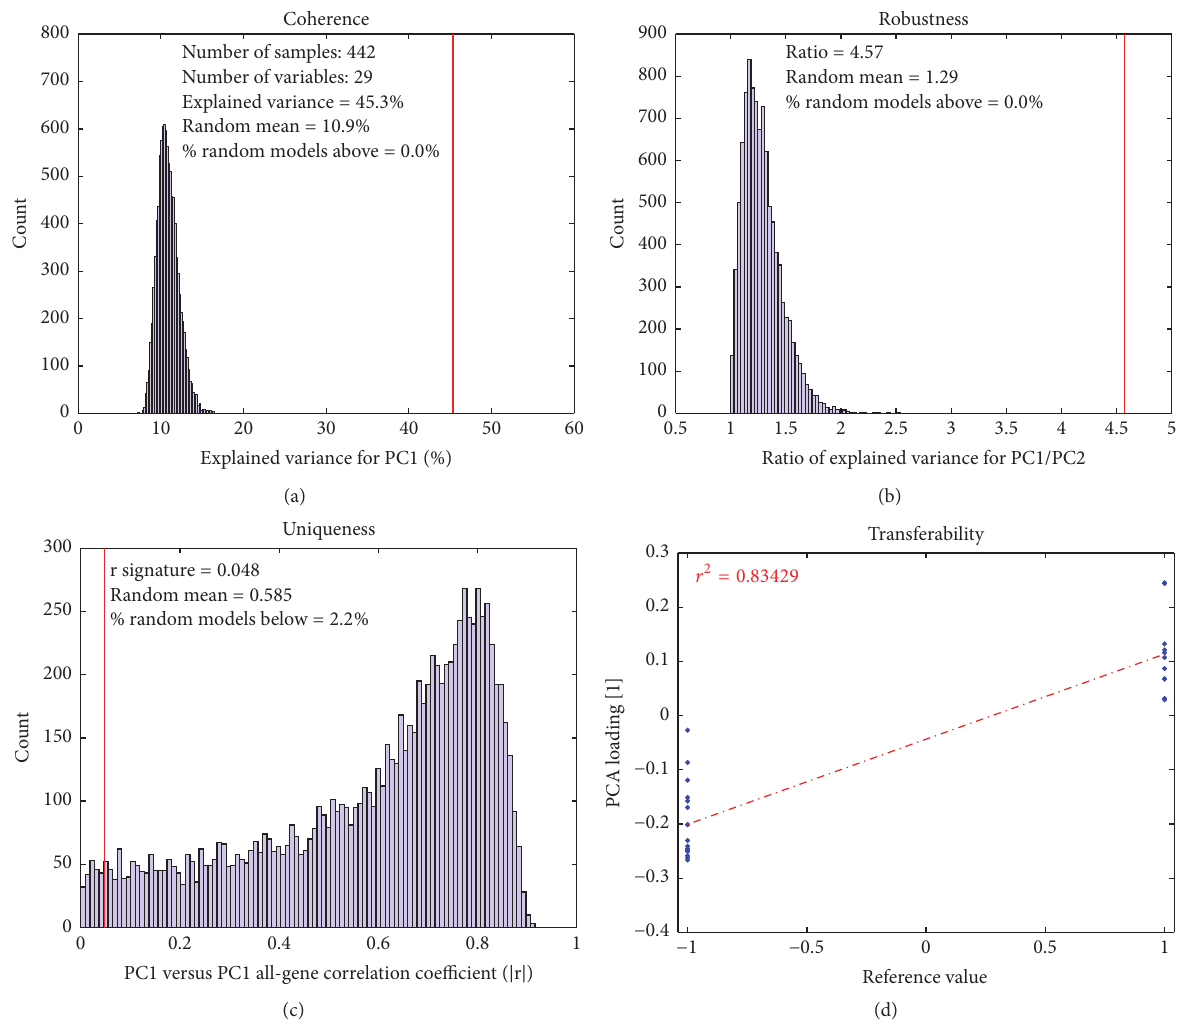
Figure 2: Validation plot for Gender-29 signature applied to DC dataset. The probesets in the Gender-29 signature show a coherent behavior when applied to the DC dataset (a). Furthermore, the PCA model is robust, with a PC1/PC2 ratio of 4.57 (b), and is unique (c). The Gender-29 signature describes gender difference, since the positive (female) probesets are positive in the PCA loadings and the male-specific probesets are negative